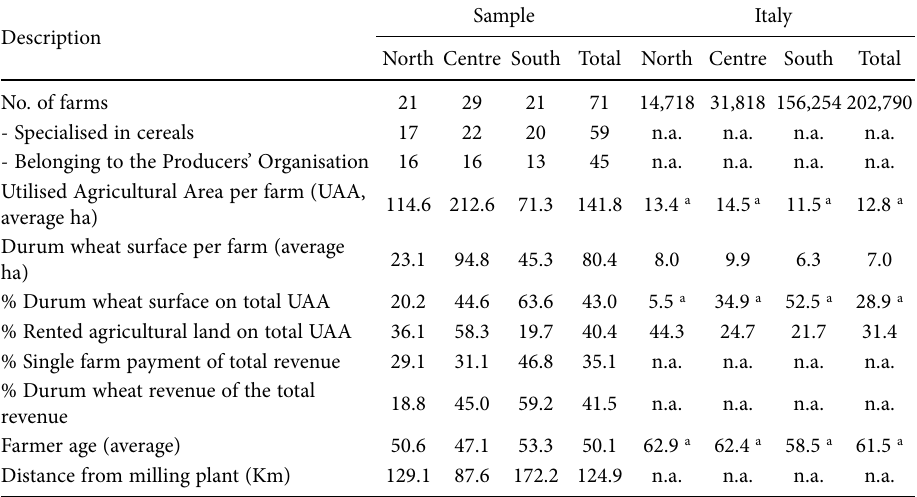
Table 1. Description of the main characteristics of the sample set and Italian farms producing durum